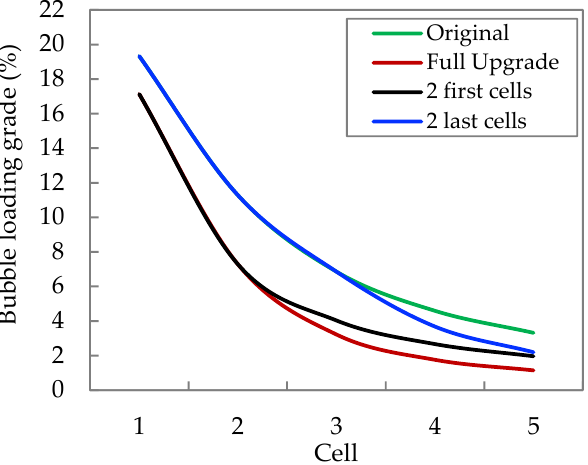
Figure 12. Bubble loading grade along the bank for the four scenarios.